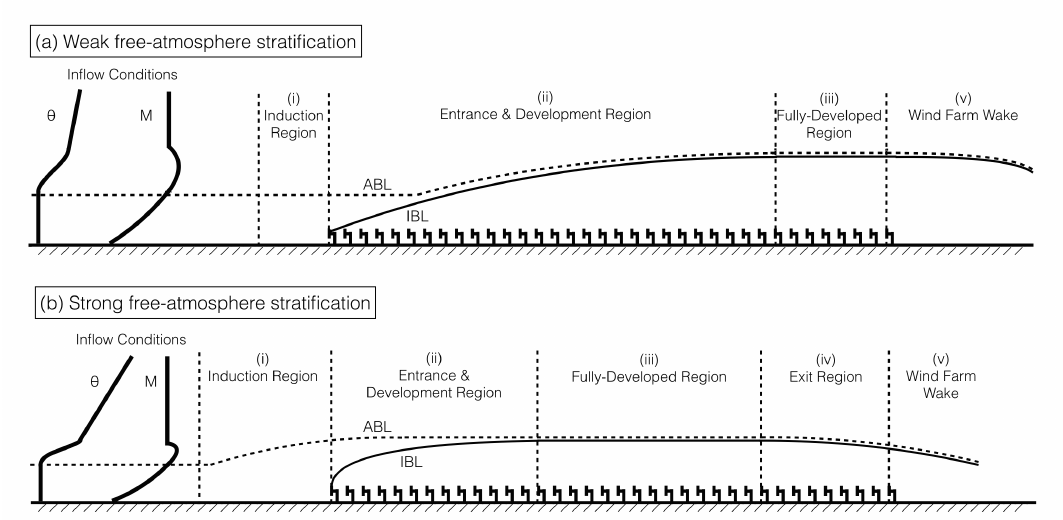
Figure 3. Flow adjustment regions in large finite-size wind farms in CNBLs with ( a ) weak and ( b ) strong free-atmosphere stratification. The flow can be divided into the following regions: (i) induction region; (ii) entrance and development region; (iii) fully-developed region; (iv) exit region; (v) wind farm